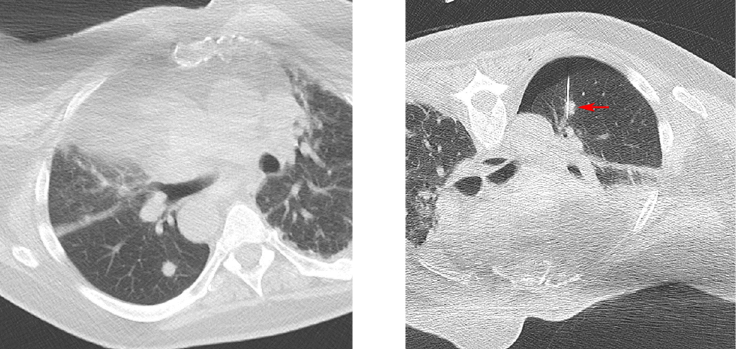
Fig 2. Example of likelihood of adequacy score 2 (equivocal). (A) Chest CT showingright lung nodule that is small and in location (behindrib) requiringangledapproach (B) Arrow points to needlein right lung nodule.Small pneumothorax is